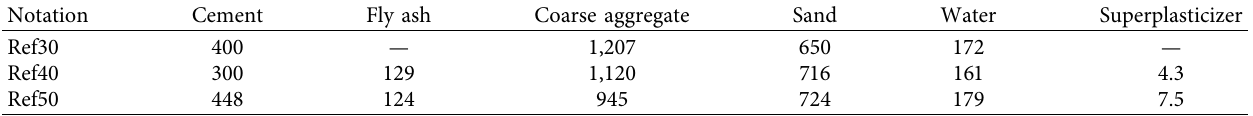
Table 1: Mix proportions of the reference concretes (kg/m 3 ).